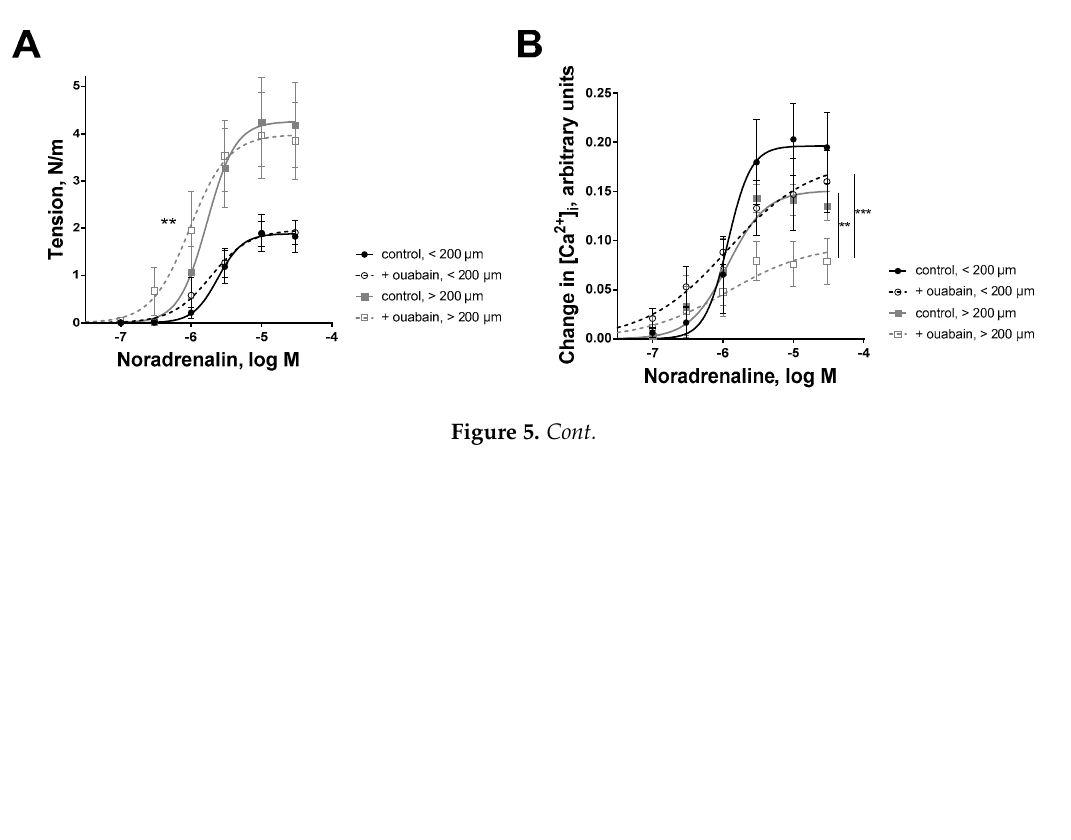
Figure 5. Ouabain has a stronger sensitizing effect on the arteries of large diameter compared to small arteries. Mesenteric arteries were subdivided into two groups; one group consisted arteries with inner diameter below 200 µm and another group consisted arteries of inner diameter above 200 µm. Arteries were loaded with the Ca 2+ -sensitive dye (Fura-2/AM) and simultaneous measurements in wall tension ( A ) and [Ca 2+ ] i ( B ) were obtained in the presence of different noradrenaline concentrations. ( C ) shows the changes in wall tension as a function of the changes in [Ca 2+ ] i for different groups under control conditions and in the presence of 10 µM ouabain, i.e., the data re-plotted from ( A ) and ( B ). The slopes of tension–[Ca 2+ ] i relations are indicated as values on the plot. Note, that the steepness of the tension– [Ca 2+ ] i relation was significantly increased for arteries with inner diameter above 200 µm. p < 0.01 (**) and p < 0.001 (***), n = 4–5. Arteries of different diameter had similar level of Y418-phosphorylated Src kinase in the wall media (Figure 6B). No correlation of Src kinase phosphorylation with arterial diameter was seen in the presence of 1 µM noradrenaline (Figure 6C). However, in the presence of ouabain, Src kinase phosphorylation positively correlated with arterial diameter (Figure 6C).